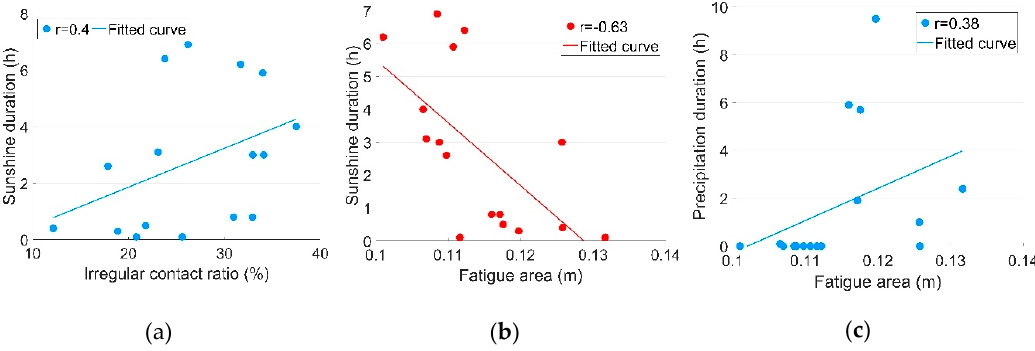
Figure 15. Cross-correlation results between the dynamic responses and weather conditions: ( a ) I r - D s ; ( b ) F a -D s ; ( c ) F a -D p .